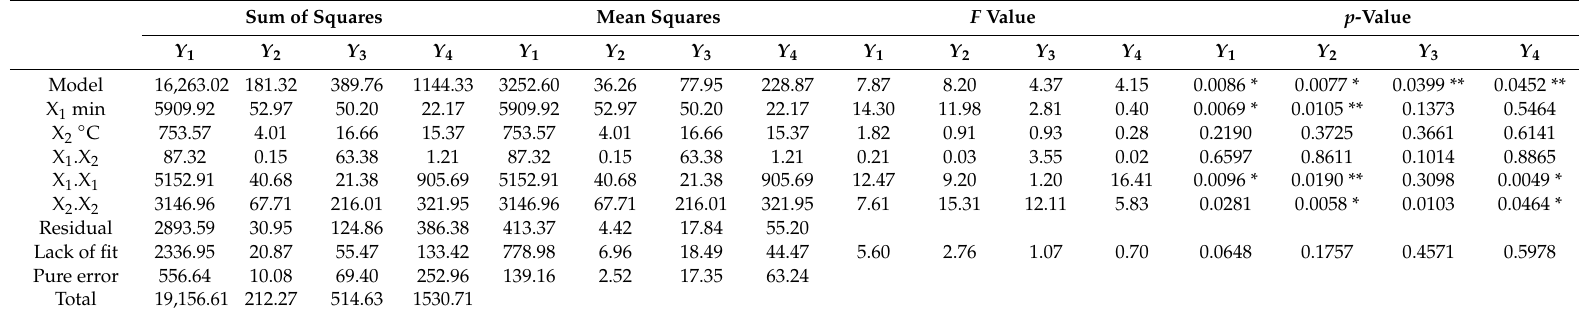
Table 2. Model summary and analysis of variance (ANOVA) of TPC (mg GAE / g dw), FRAP (IC 50 µ g / mL), DPPH (IC 50 µ g / mL) and ABTS (IC 50 µ g / mL) of C. sativa shells